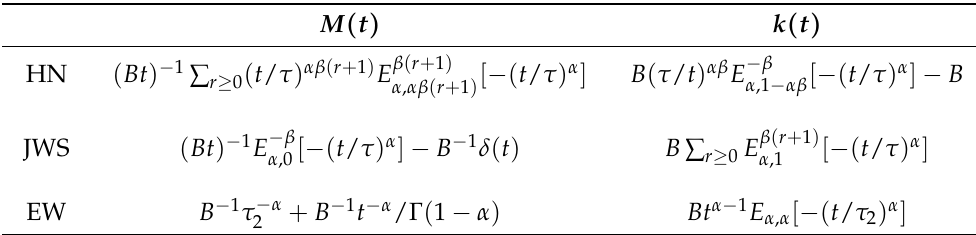
Table 2. M ( t ) and k ( t ) for the HN, JWS, and EW